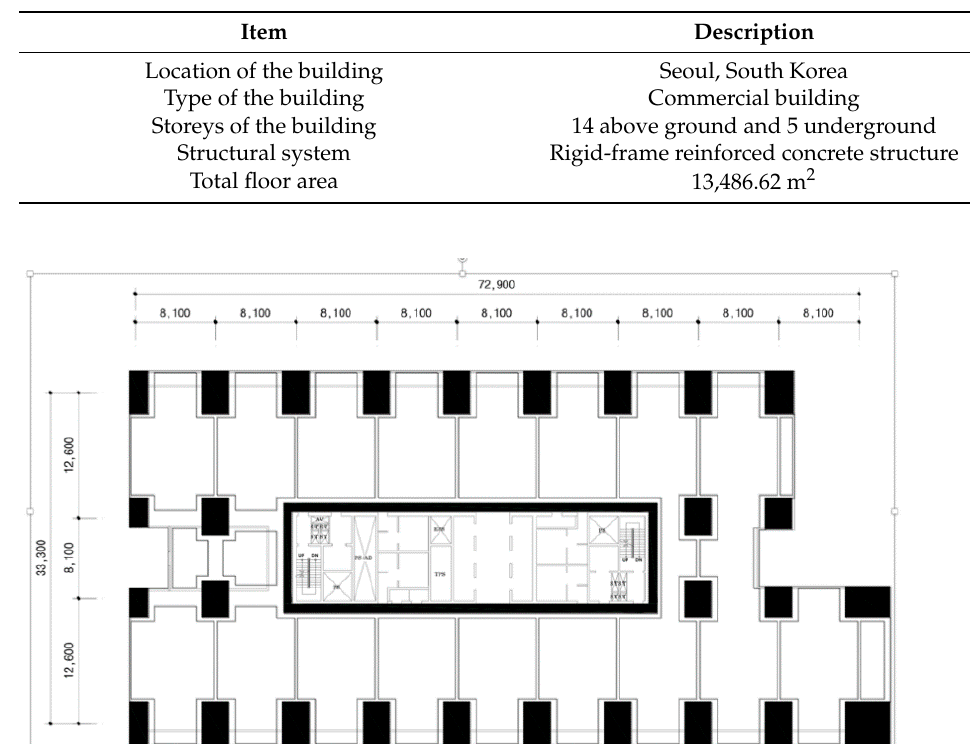
Table 2. The profile of the case study building.